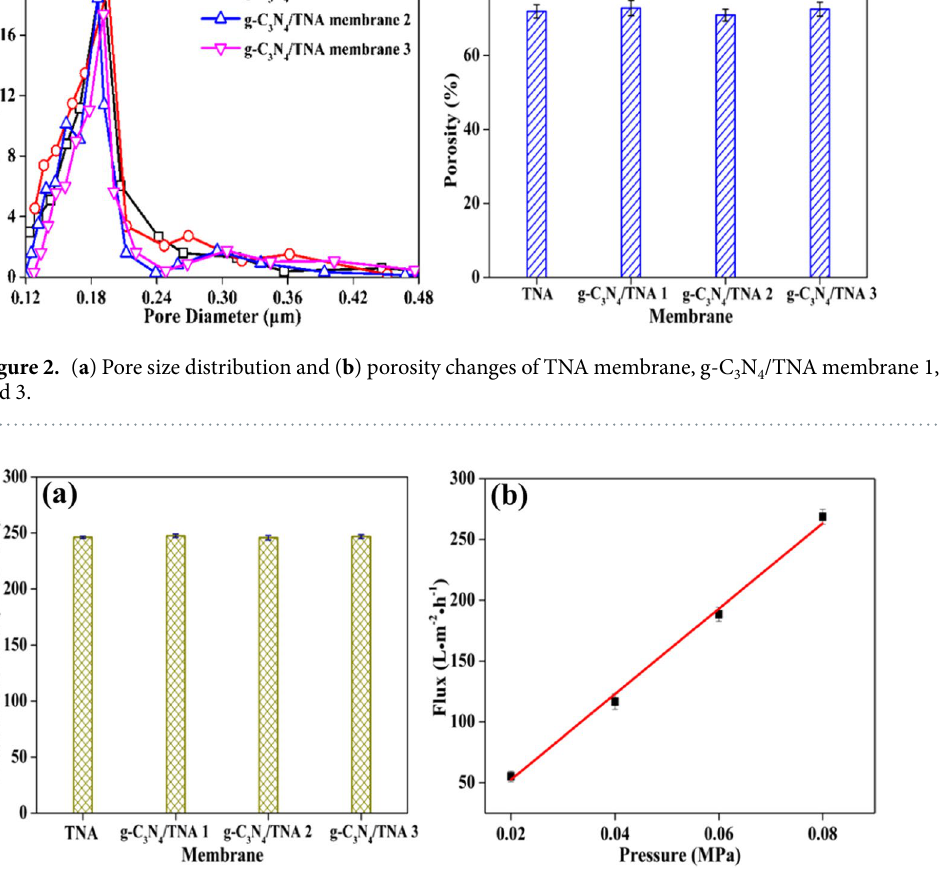
Figure 1e shows a representative TEM image of the g-C 3 N 4 /TNA with a hollow tube-like structure. The high-resolution TEM image of the g-C 3 N 4 /TNA exhibited that the material was crystalline with an interpla- nar spacing of 0.353 nm (bottom left of Fig. 1e), which corresponded to the (101) planes of anatase TiO 222–25 . The lattice spacing of 0.336 nm (top left of Fig. 1e) is indexed to the (002) planes of hexagonal g-C 3 N 426, 27 . The membrane hydrophilicity of g-C 3 N 4 /TNA membrane was evaluated by measuring their water contact angles. A good hydrophilicity is beneficial to the permeating performance of membranes. Figure 1f presents that the water contact angle of all the g-C 3 N 4 /TNA membranes is lower than 12°. Meanwhile, it can be also seen that the effect of g-C 3 N 4 QDs on g-C 3 N 4 /TNA membrane hydrophilicity is neglected. Figure 2a presents the pore size distribution obtained from the g-C 3 N 4 /TNA membranes. For comparison, the pore size distribution of TNA membrane was also measured. Apparently, all the samples exhibit the same mean pore size of about 190 nm, which indicated that the deposition of g-C 3 N 4 QDs did not markedly affect the pore size distribution of membranes and the mean pore size did not decreased with the increasing of g-C 3 N 4 QDs dep- osition time. The results of mean pore size measurement were in agreement with the observation of SEM image of g-C 3 N 4 /TNA membranes. On the other hand, the porosity of TNA membrane and g-C 3 N 4 /TNA membranes is displayed in Fig. 2b. The porosity of both TNA membrane and g-C 3 N 4 /TNA membrane 1, 2 and 3 were same at about 72%. Since the porosity of traditional separation membranes is lower than 36% 28 , the high porosity of g-C 3 N 4 /TNA membrane could be attributed to its unique membrane structure including straight channels and highly self-ordered arrangements. Meanwhile, it can be seen from Fig. 2b that the effect of deposition of g-C 3 N 4 QDs on the membrane porosity could be neglected. The membrane permeability was evaluated by testing pure water flux of membranes. As shown in Fig. 3a, com- pared with the TNA membrane, the pure water flux of all the g-C 3 N 4 /TNA membranes is about 250 L · m − 2 · h − 1 (0.075 MPa). This indicated that the effect of g-C 3 N 4 QDs immobilization on the pure water flux of TNA mem- brane could be negligible under present experimental conditions. Figure 3b exhibits the pressure dependence of pure water flux for g-C 3 N 4 /TNA membrane. The flux increased linearly with applied pressures (0.02~0.08 MPa), indicating a high compressive resistance of the membranes used for filtration.